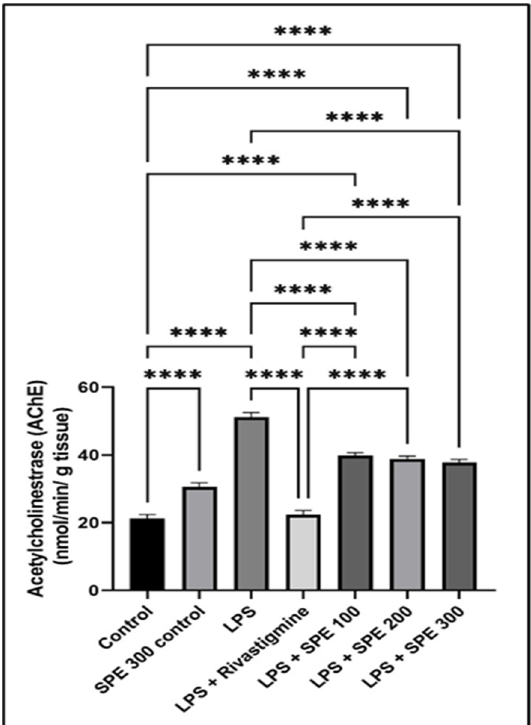
Figure 6. The acetylcholinesterase (AChE) activity of the control (group 1), SPE 300 control (group 2), LPS (group 3), LPS + Rivastigmine (group 4), LPS + SPE 100 (group 5), LPS + SPE 200 (group 6), and LPS + SPE 300 (group 7). ****: Significant at p ≤ 0.0001.